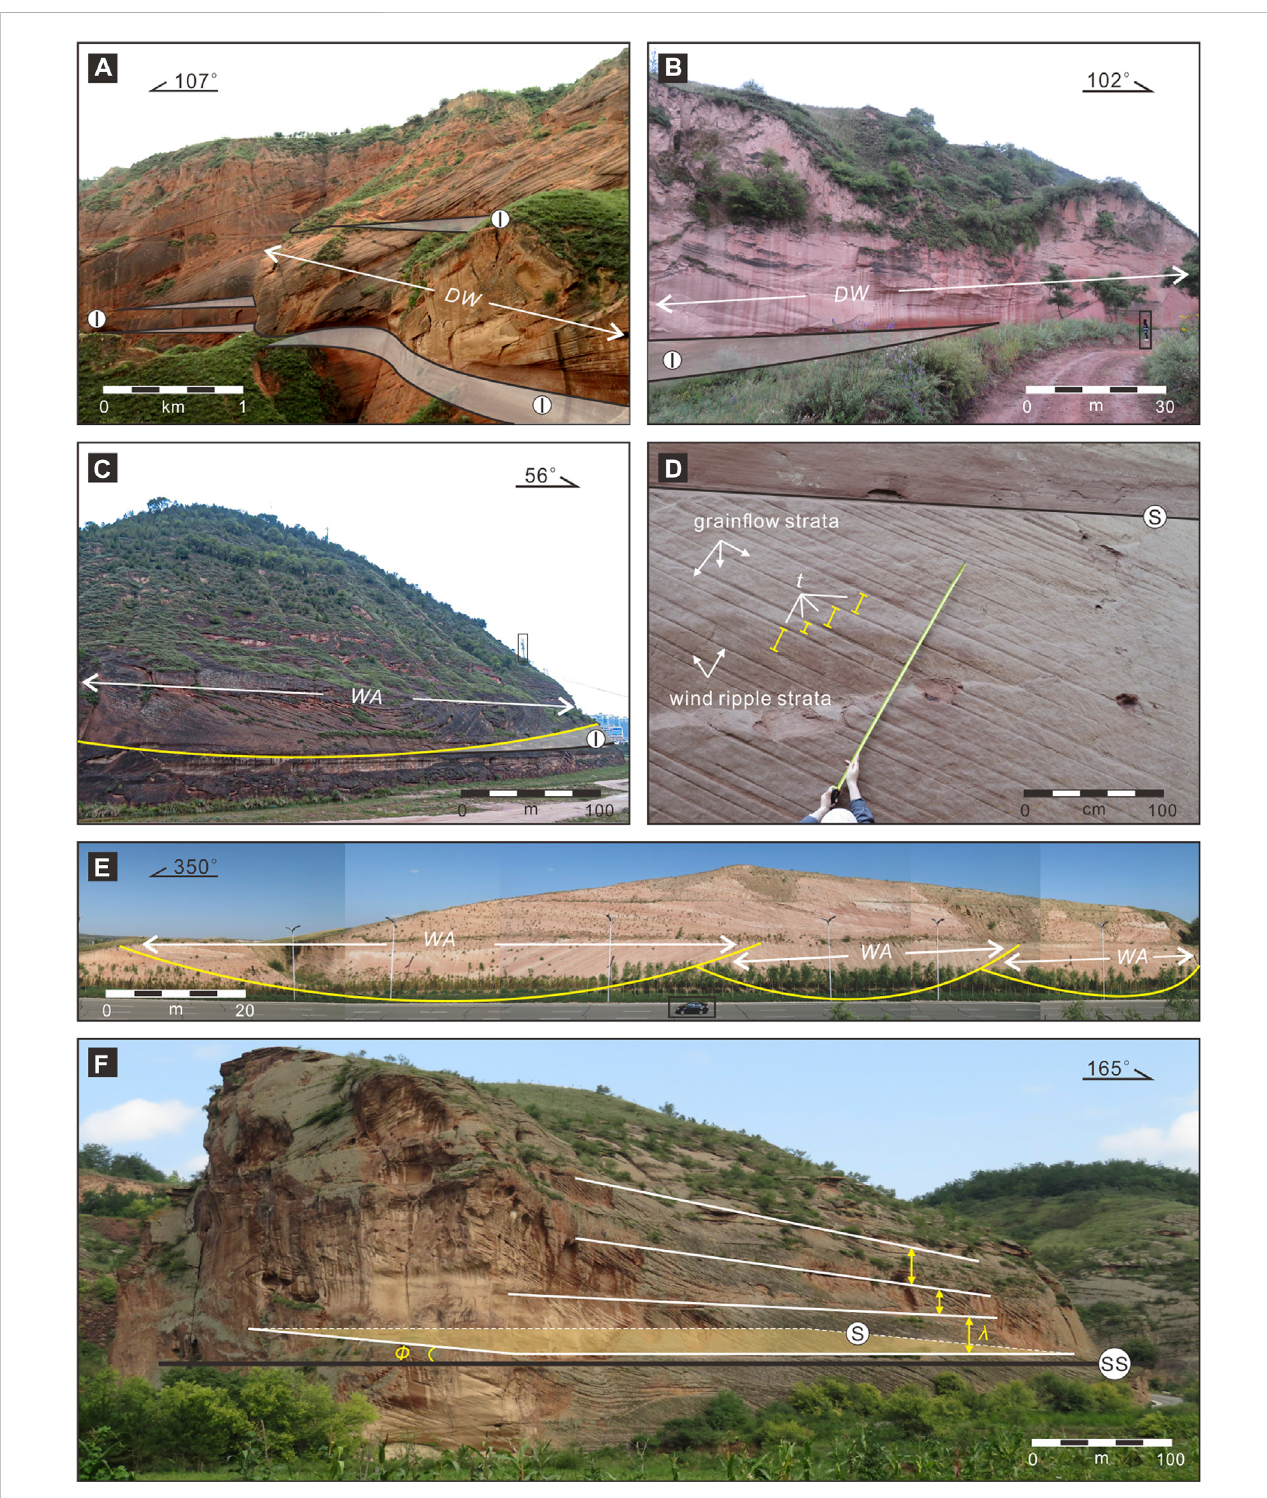
FIGURE 3 Outcrops of morphological parameters of ancient dunes. (A) Dune deposit bounded on both sides by interdune deposits in the section nearly parallel to the paleowind. (B) Dune deposit bounded on one side by interdune deposit in the section nearly parallel to the paleowind. (C) Large-scale aeolian though cross-bedding with interdune deposits in the section nearly perpendicular to the paleowind. (D) Detail of aeolian cross-bedding showing grain fl ow and grainfall lamination. (E) A series of cross-beddings in the section perpendicular to the paleowind. (F) Large-scale compound aeolian dunes in the paleo- desert center. SS-Supersurface; I-interdune surface; S-superimposed surface; DW -dune wavelength; WA -dune wave width; t -grain fl ow thickness; λ - preserved set thickness; ϕ -angle of set